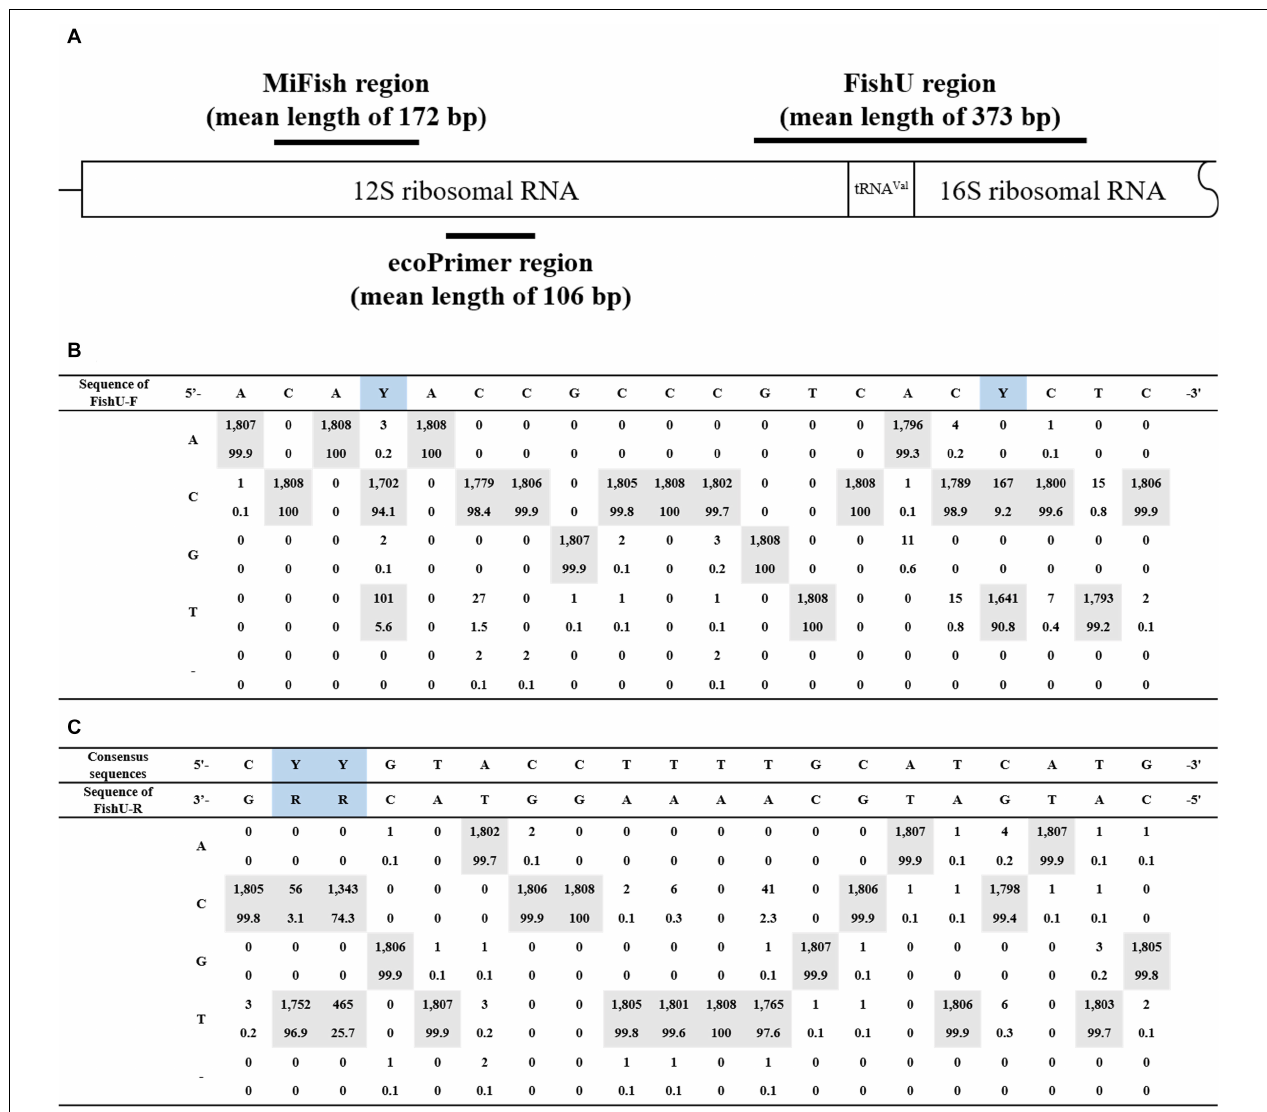
FIGURE 1 | Primer region schematic representation. (A) The position of the primer used in this study is represented in the structure of general mtDNA, including 12S and 16S rRNA genes. MiFish has a mean length of 172 bp; FishU has a mean length of 373 bp. (B) Consensus nucleotide sequences of the forward primer. (C) Consensus nucleotide sequences of the reverse